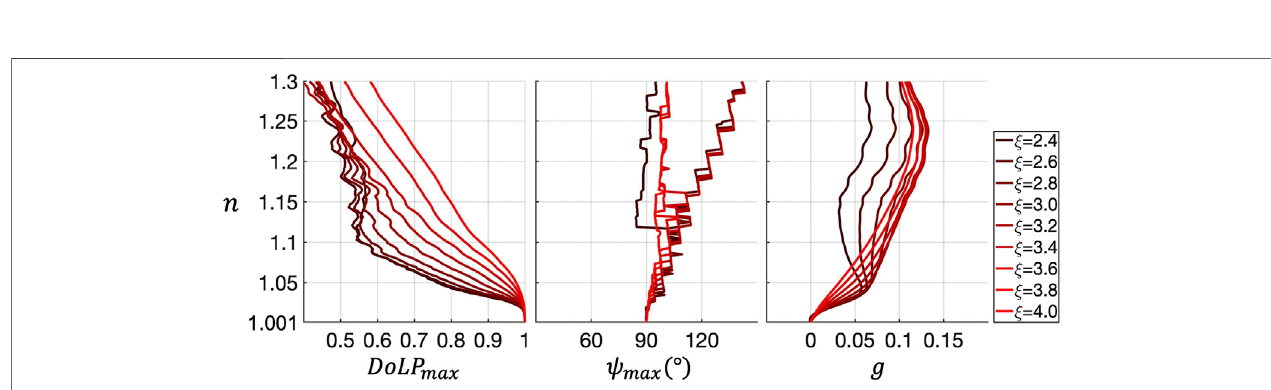
FIGURE 2 | Particulate refractive index n plotted against peak magnitude DoLP max , peak angle ψ max and asymmetry parameter g of the Lorenz-Mie DoLPs (Figure 1 ) for different PSD slopes ξ .